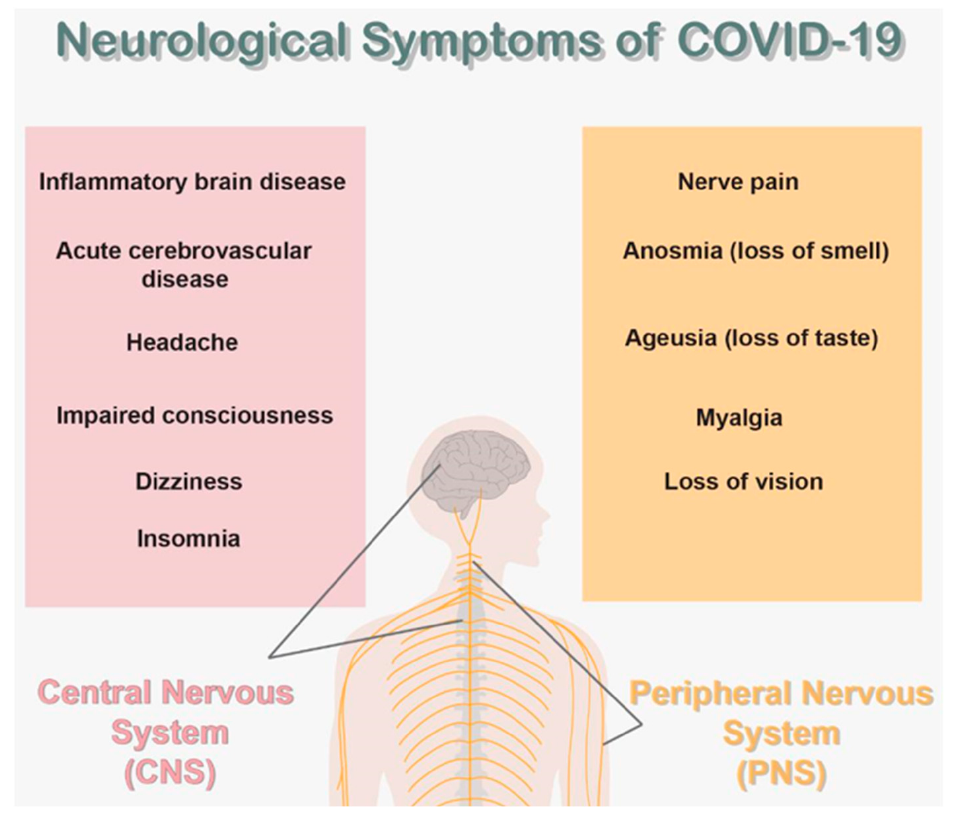
Figure 3. Neurological symptoms of COVID-19.